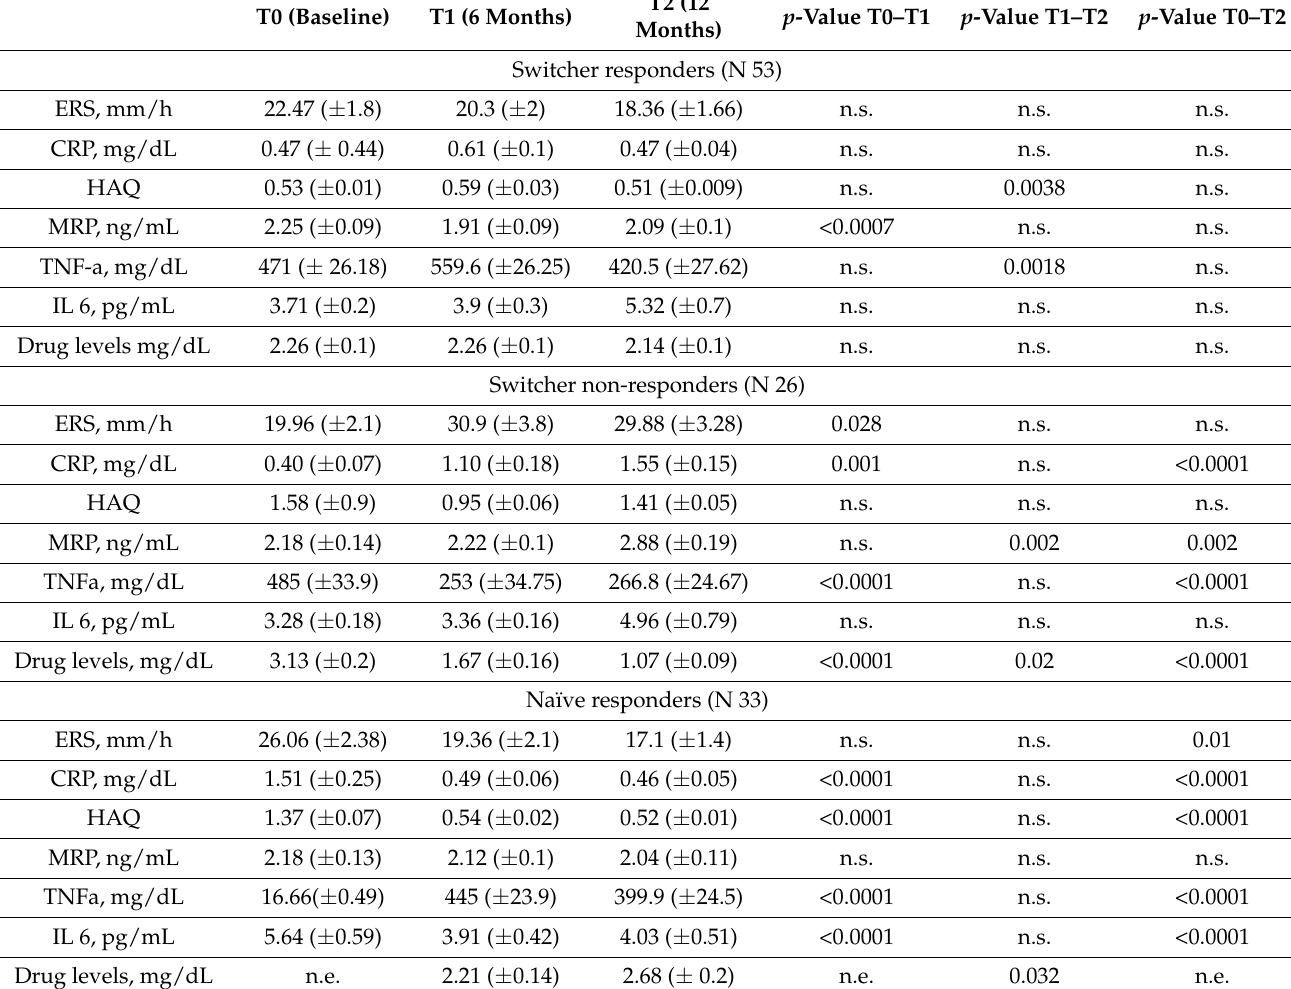
Table 3. Differences in clinical and laboratory biomarkers between baseline, 6 (T1), and 12 months (T2) of follow-up in switcher responder, switcher non-responder, naïve responder, and naïve non- responder patients (values expressed mean, SEM, and p significance <